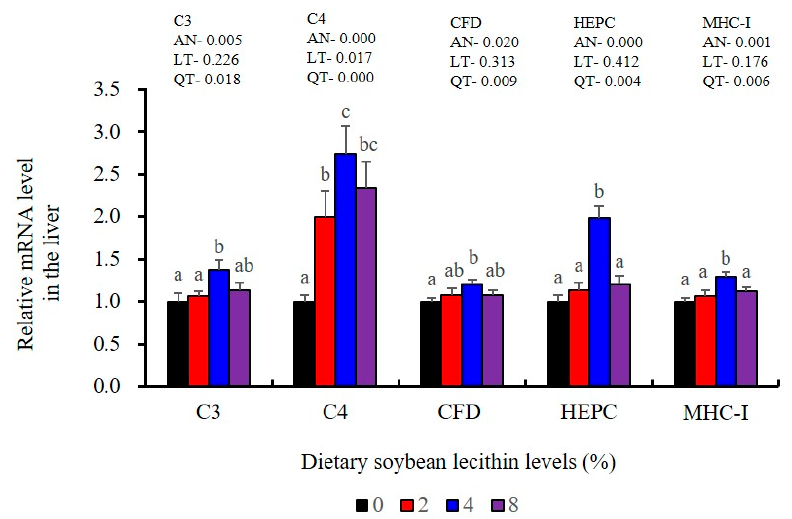
Figure 5. Effect of dietary soybean lecithin on relative gene expression levels of anti-inflammatory Figure 5. E ff ect of dietary soybean lecithin on relative gene expression levels of anti-in fl ammatory and pro-inflammatory cytokines in the liver of juvenile largemouth bass. Bars with different letters and pro-in fl ammatory cytokines in the liver of juvenile largemouth bass. Bars with di ff erent le tt ers indicate significant differences ( p < 0.05), while that with the same letter or no letter superscripts indicate signi fi cant di ff erences ( p < 0.05), while that with the same le tt er or no le tt er superscripts indicate no significant differences ( p > 0.05), AN: ANOVA, LT: linear trend, QT: quadratic trend. indicate no signi fi cant di ff erences ( p > 0.05), AN: ANOVA, LT: linear trend, QT: quadratic trend.